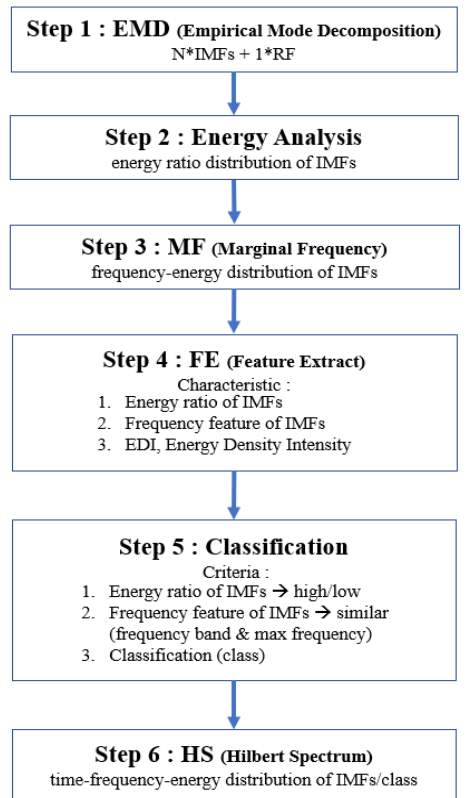
Figure 1. Feature extraction algorithm with six main steps. (1) Empirical Mode Decomposition